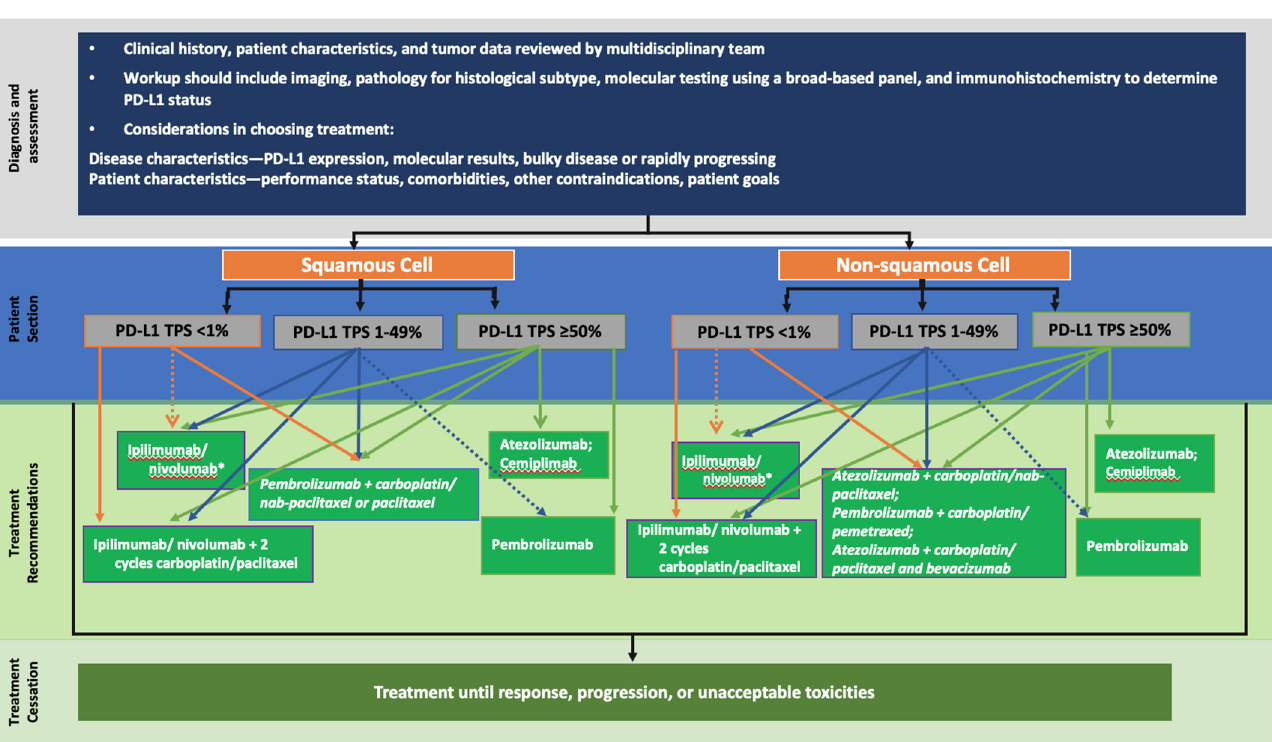
Figure 2. Potential treatment paradigm in the US for NSCLC without actionable mutations in front line. Adapted from [71,73]. * Not FDA approved for PD-L1 < 1%.